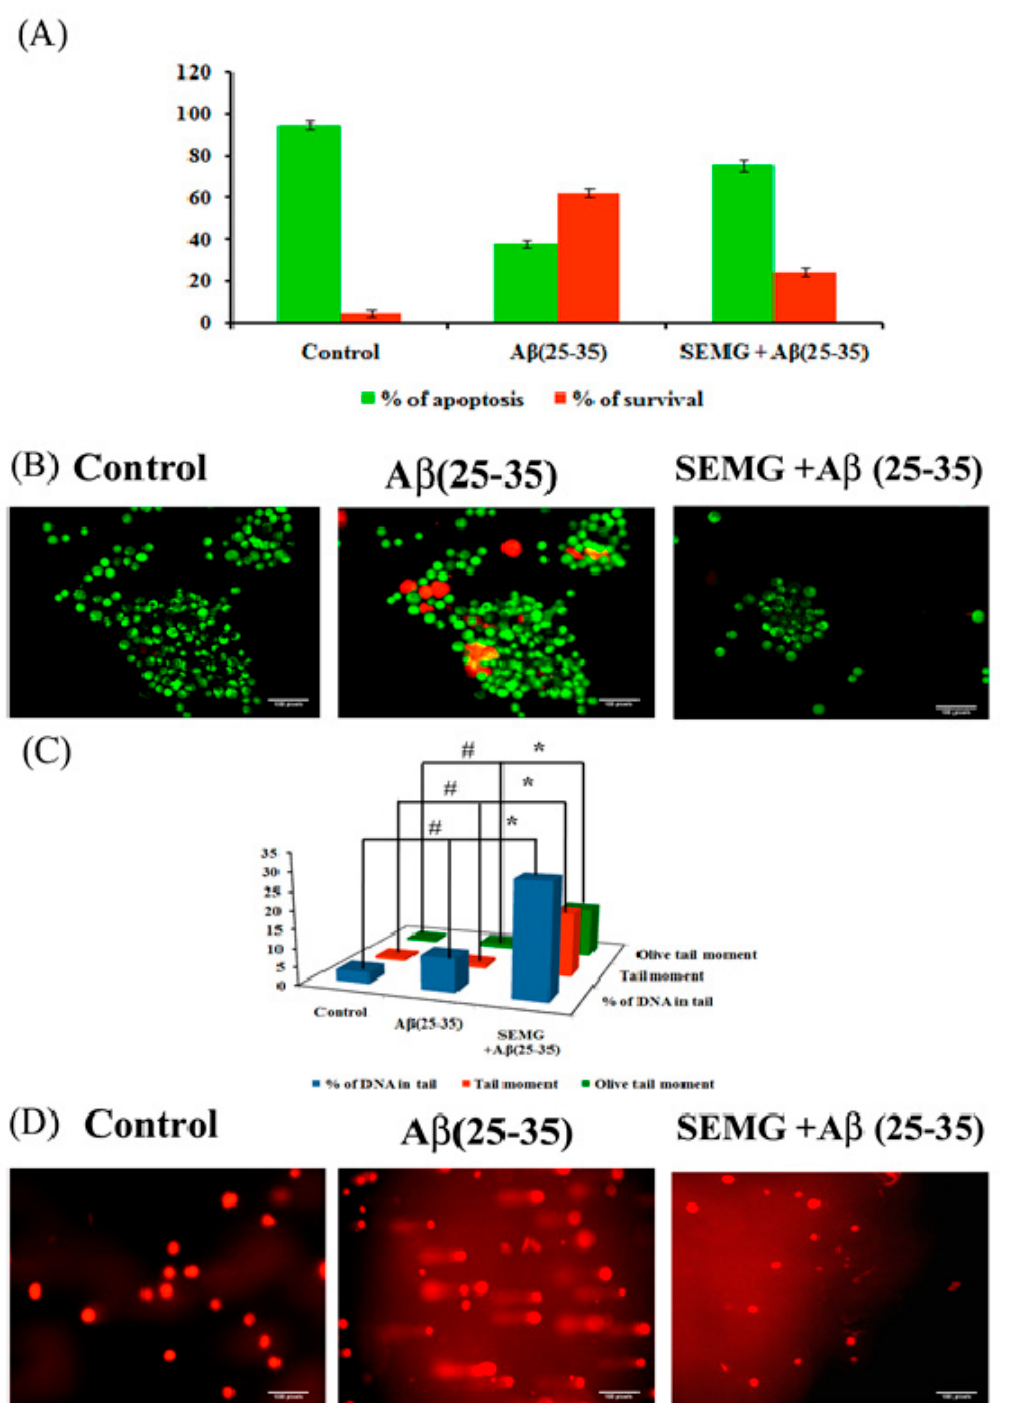
Figure 9. Assessment of antiapoptotic effect of SEMG in A β treated Neuro2A cells by Acridine orange/Ethidium Bromide dual staining technique ( A ) Quantification of apoptotic population; ( B ) Fluorescent microscopic image revealing the presence of viable cells, apoptotic and necrotic cells * & # p < 0.05 denotes the statistical significance between the control and treated groups with respect to viable and apoptotic cells; ( C ) Bar diagram illustrating the SEMG ability to attenuate the DNA damage in cells treated with A β (25–35); ( D ) Fluorescent microscopic images illustrating the DNA damaging effect of A β (25–35) treatment and attenuating effect of SEMG by comet assay at 20 × magnification. Data are expressed as mean ± SD of triplicate assays. Images were captured at 20 × magnification respectively.